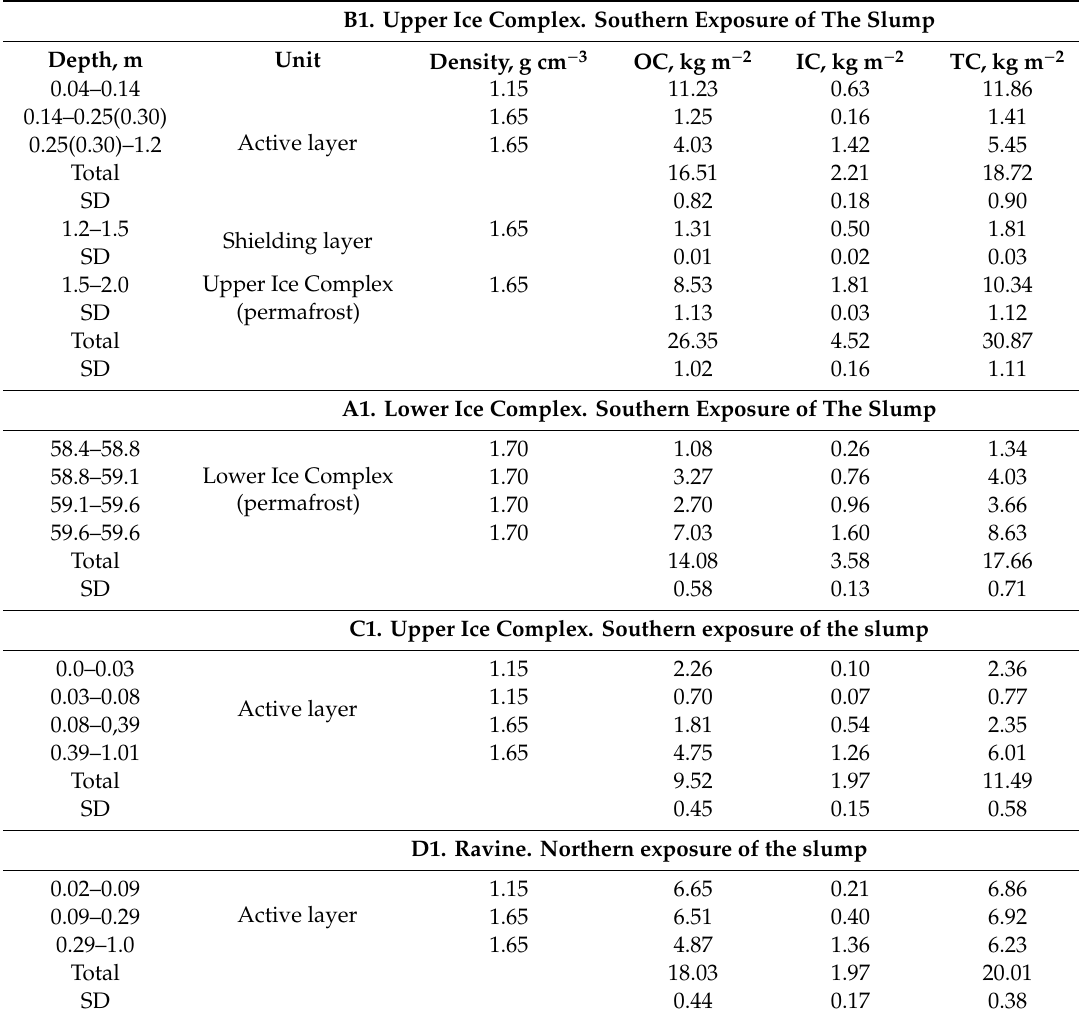
Table 3. Carbon stocks of di ff erent facies features of the Batagay megaslump. B1. Upper Ice Complex. Southern Exposure of The